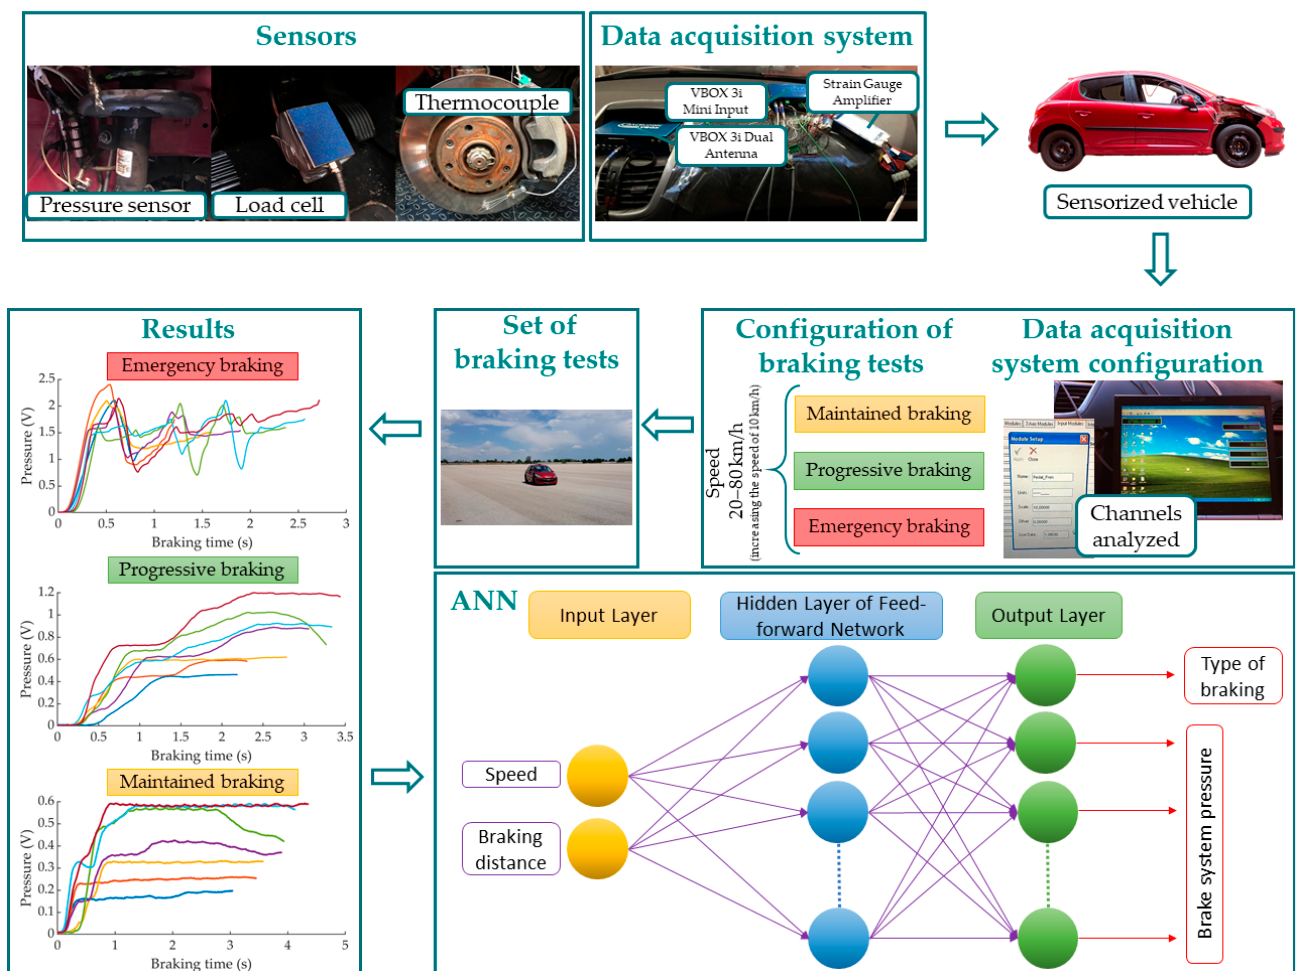
Figure 1. Methodology followed for the development of the study presented in this article.